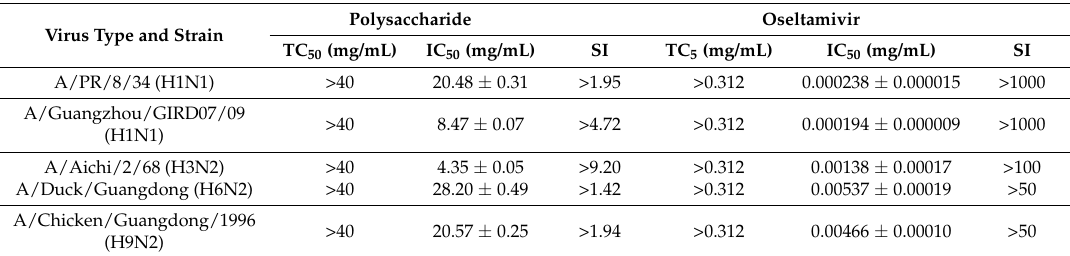
Table 1. Anti-influenza virus activities of the polysaccharides in